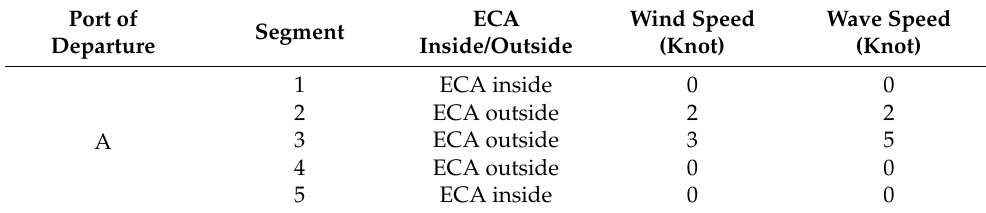
Table 8. Wind speed and wave